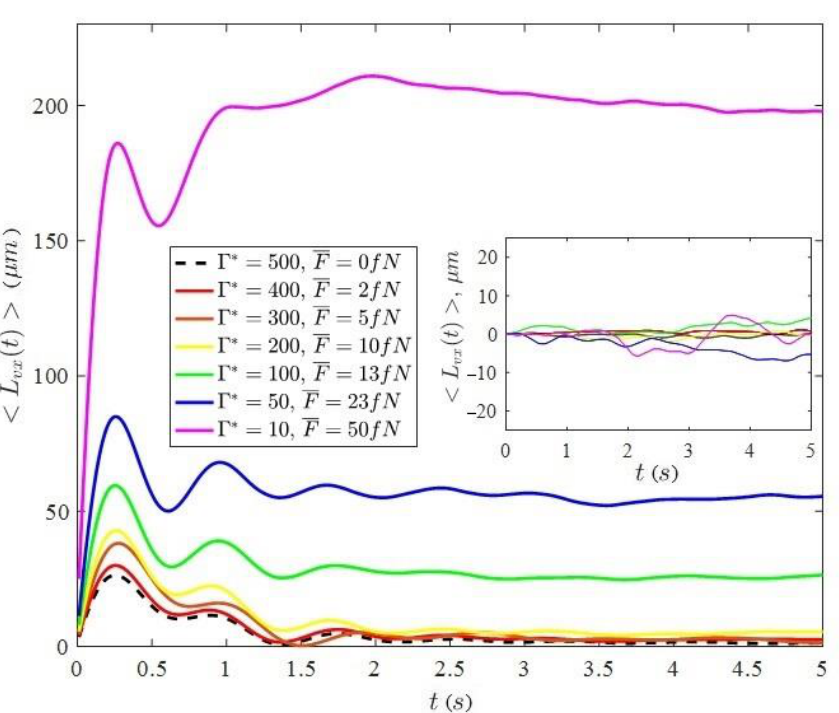
Figure 5. Average linear displacements along the vector of initial velocities for particles with a metal coating in a plasma-dust monolayer at different power levels of the acting laser radiation.